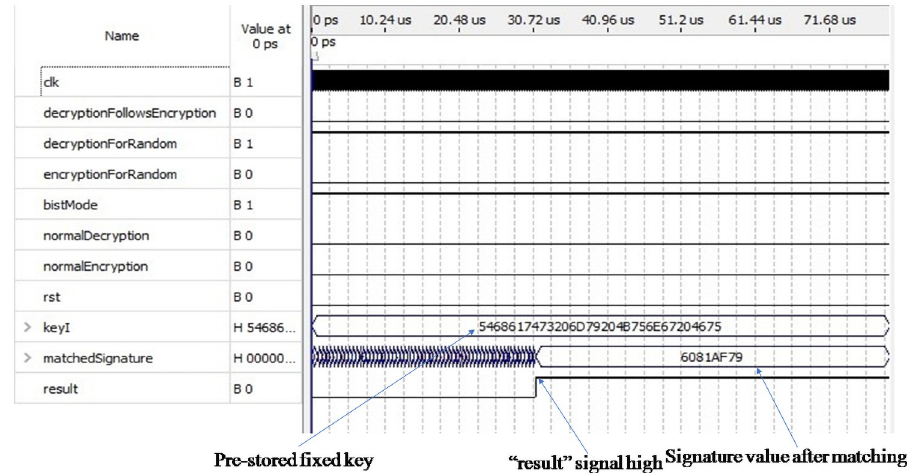
Fig 9. Simulation result of decryption module in test mode.